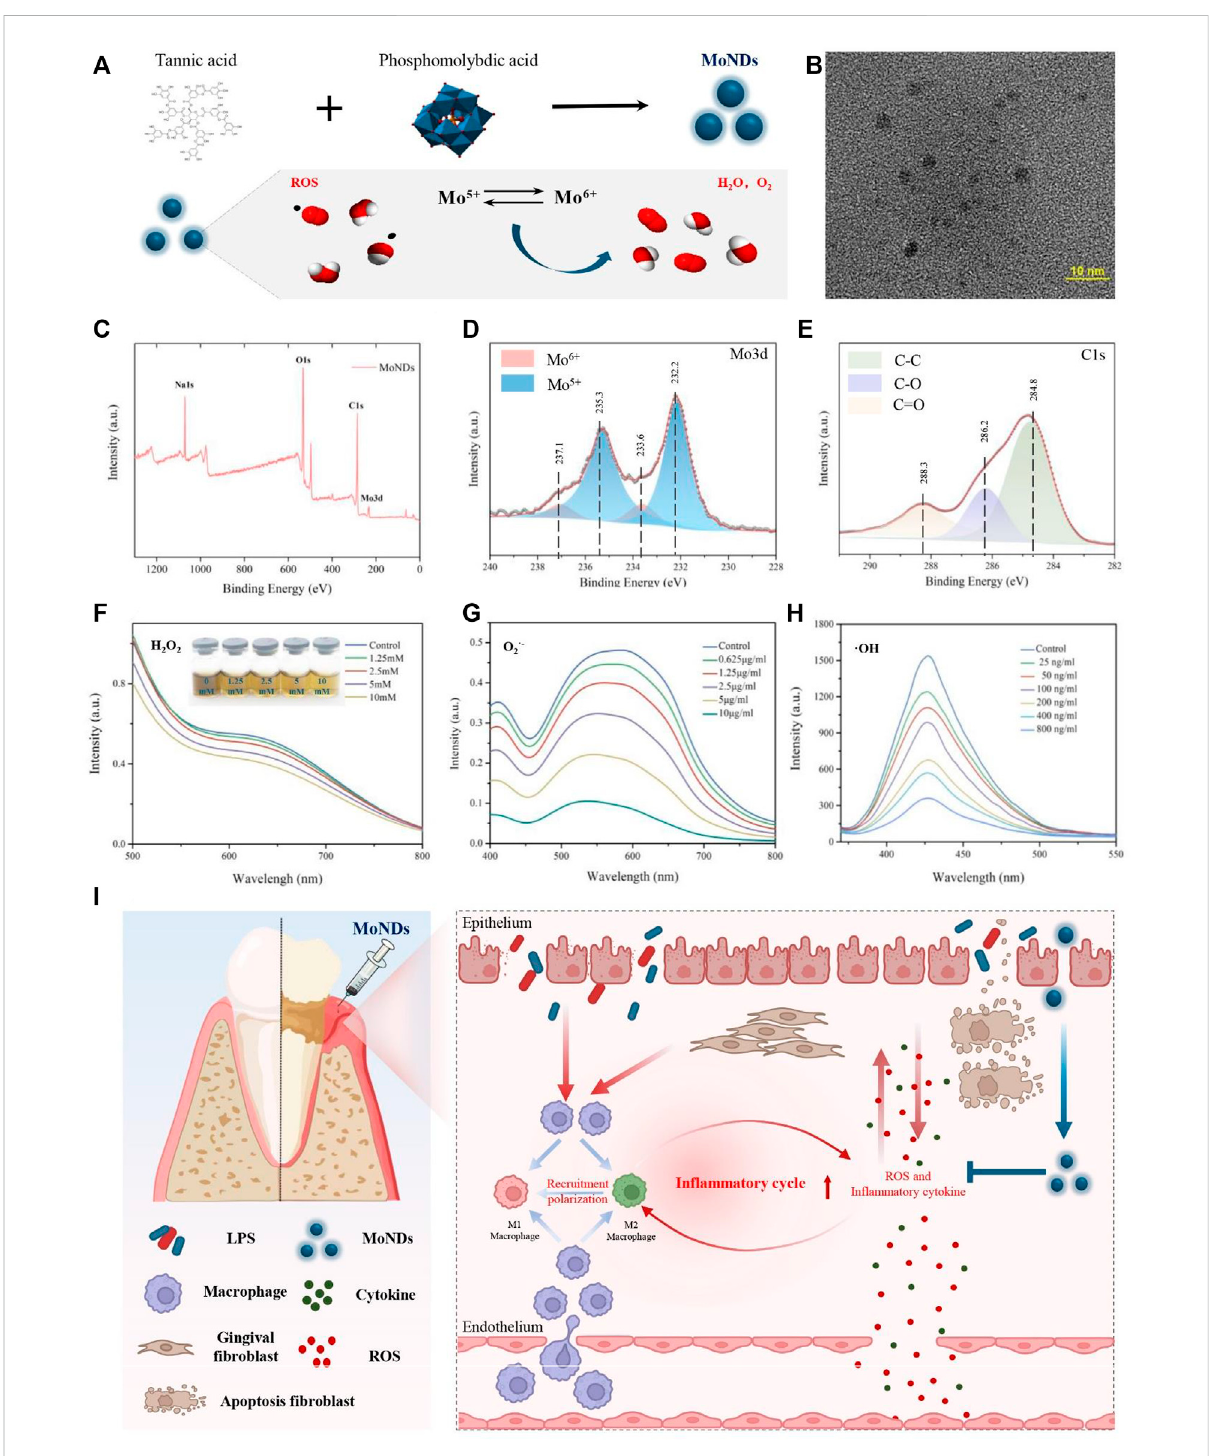
FIGURE 1 Preparation and characterization of MoNDs. (A) Schematic illustration of the preparation and ROS scavenging capacity of MoNDs. (B) TEM imageofMoNDsinwater,scalebar:10 nm. (C – E) XPSspectrumofMoNDs.H 2 O 2 (F) ,O 2 .- (G) ,andOH (H) scavengingabilityofMoNDs. (I) Schematic illustration showing MoND treatment of mice with PD. After subgingival injections, MoNDs were effectively accumulated in gingival tissue through the damaged endothelium. As a ROS scavenger, MoNDs protected gingival fi broblasts from oxidative stress and alleviated ROS-induced apoptosis. In addition, MoNDs had the capacity to control in fl ammation via regulating macrophage polarization and